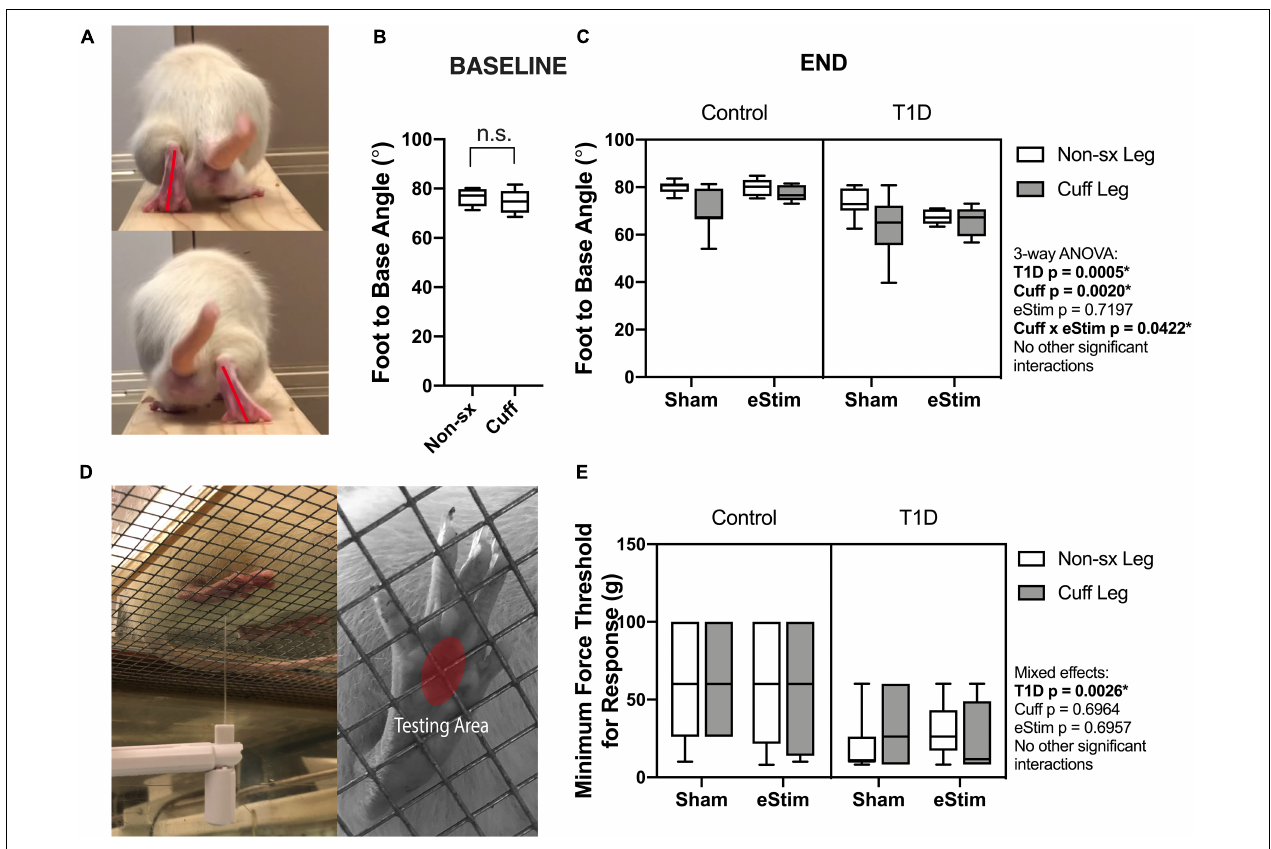
FIGURE 4 | Neuromuscular behavioral assessments. (A) Foot to base angle (FBA) was measured using single frame motion analysis (SFMA). (B) Baseline FBA measurements at 10 weeks of age. (C) End point FBA measurements at 23-week of age. Manual von Frey filaments were also applied to the midplantar surface of the hindpaw (indicated by a red circle) (D) . (E) Minimum force threshold for response at end point. Statistics for baseline FBA measurements was performed by paired t -test. Control, sham n = 7; Control, eStim n = 6; Diabetic, sham n = 8; Diabetic, eStim n = 5; three-way ANOVA with repeated measures (Non-sx Leg vs. Cuff Leg); * p <